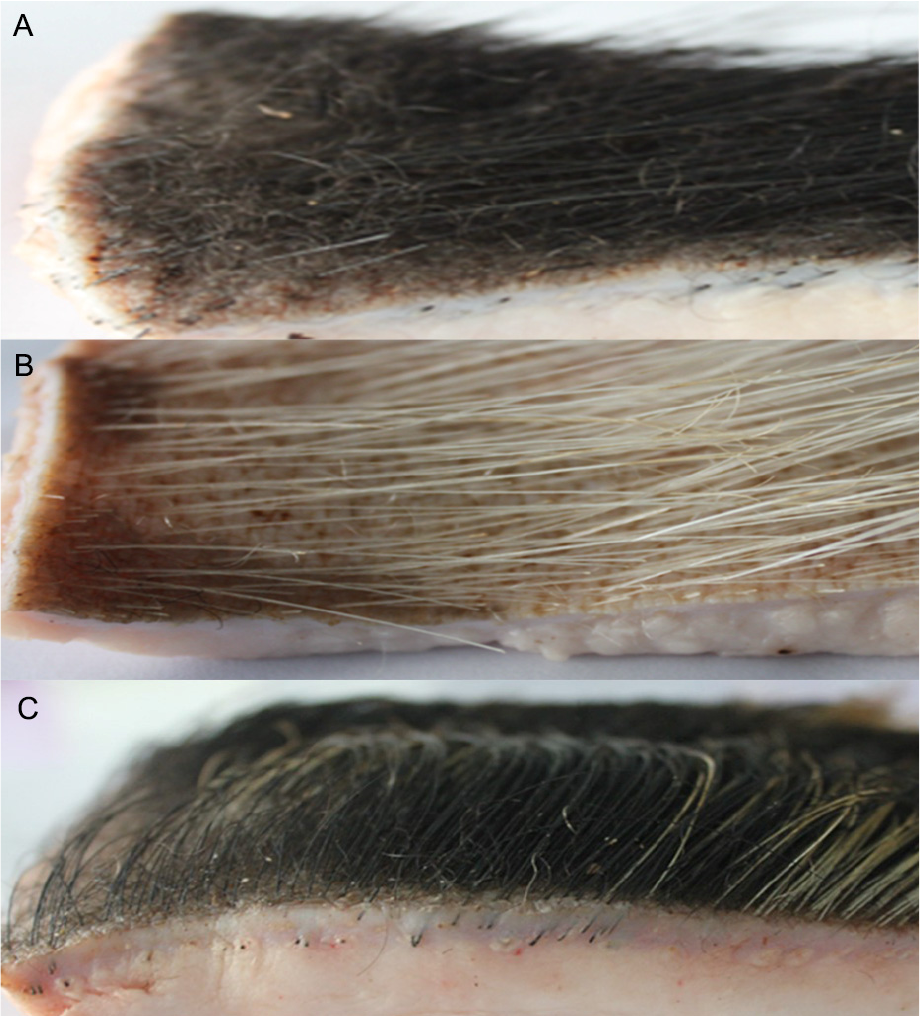
Figure 2. The fur phenotypes of the Min pig ( A ), Yorkshire pig ( B ), and Berkshire pig ( C ).